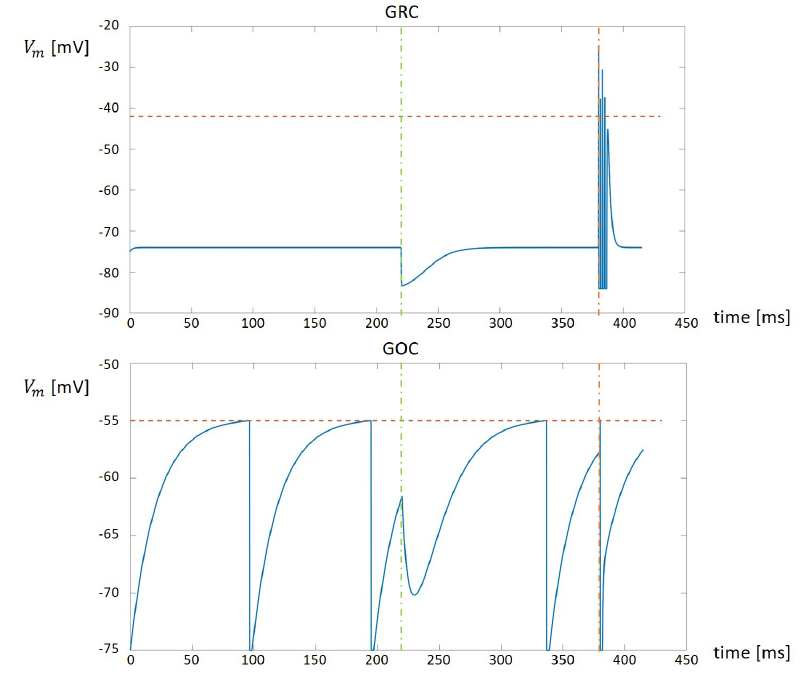
Figure 3. The results produced by the single cells C